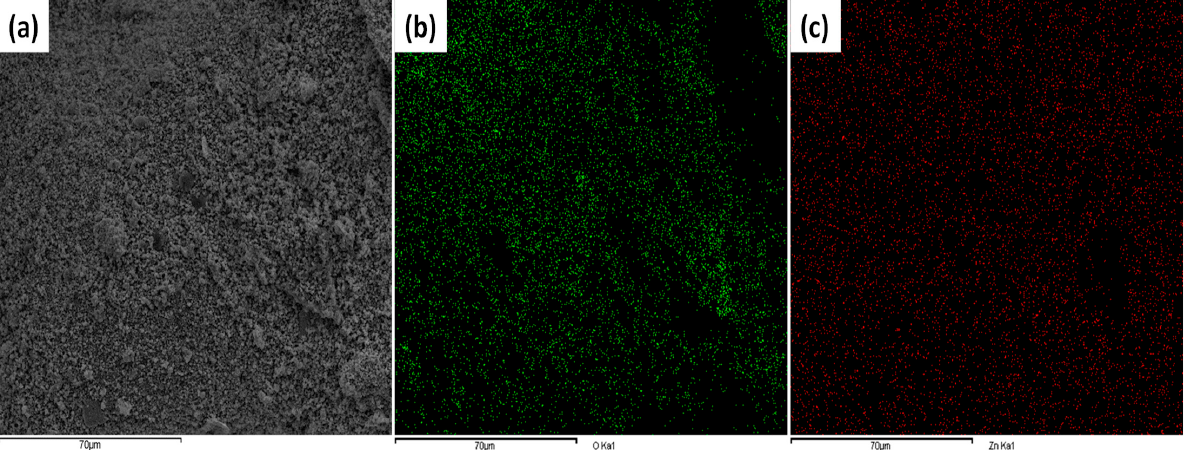
Figure 3. ( a ) Elemental mapping of ZnO, ( b ) Zn, and ( c ) O elements of ZnO-NPs biosynthesized using extract of C. chinense fruits.